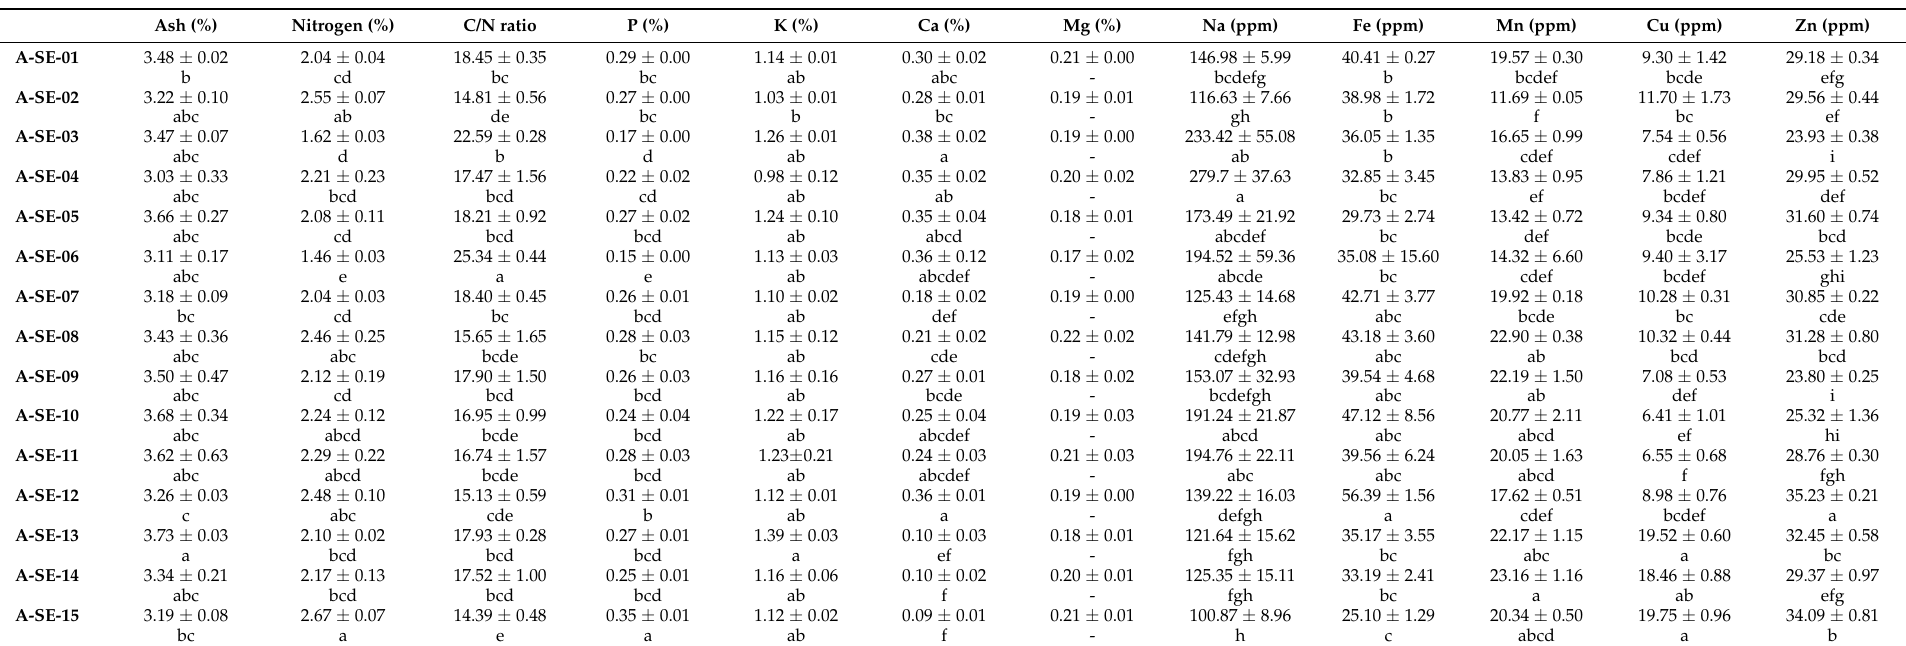
Table 1. Mineral seed contents. Mean ± SD mineral contents are presented as a percentage of seed weight (P, K, Ca, and Mg) or as mg/Kg (Na, Fe, Cu, Mn, and Zn). Statistical analysis following a Kruskal–Wallis test by ranks (P, K, Mg, Na, Mn, Cu, and Zn content) or a Welch’s ANOVA with a Games–Howell post-hoc test (Ca and Fe contents) were performed. Different letters under each mineral content show statistically significant differences between